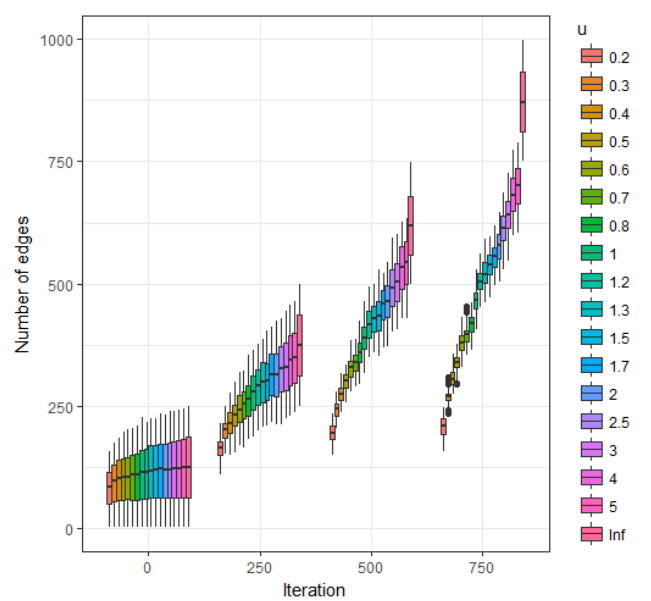
Figure 3. Estimated expected value of number of edges as a function of u at iterations 250, 500, 750 and 1000.